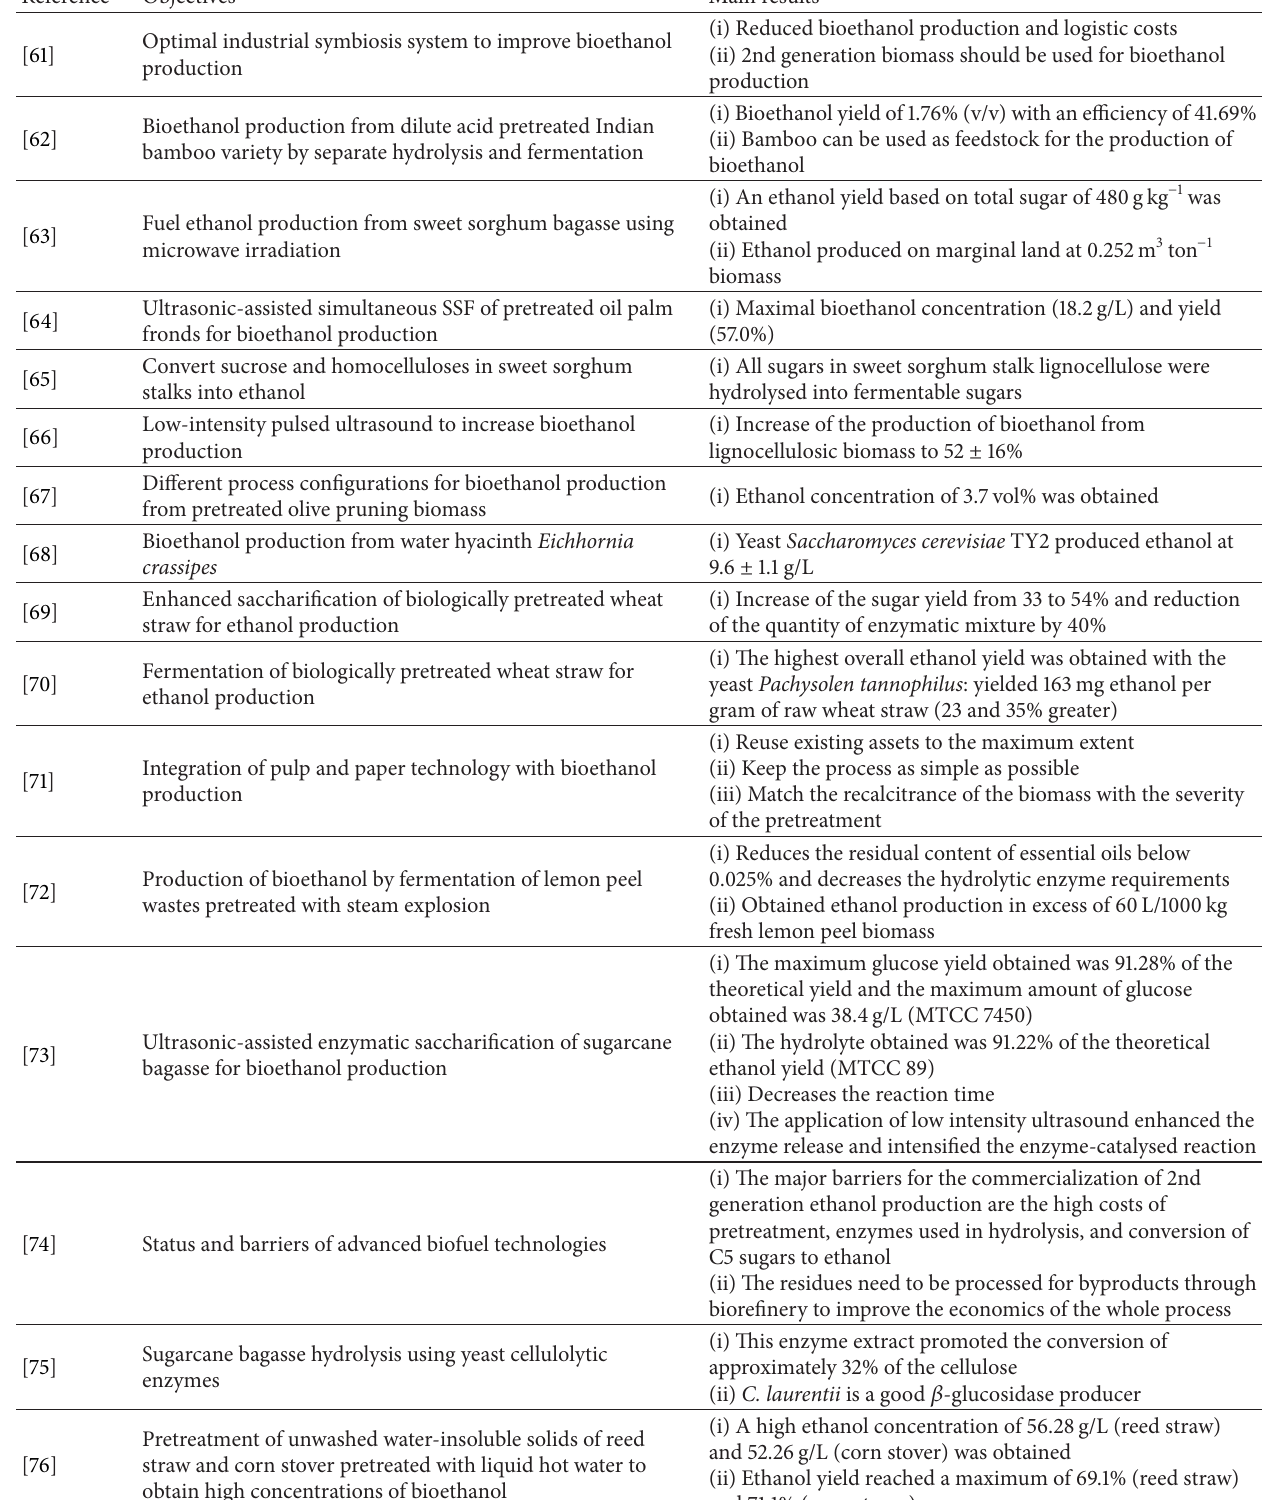
Table 2: Recent literature about second generation bioethanol